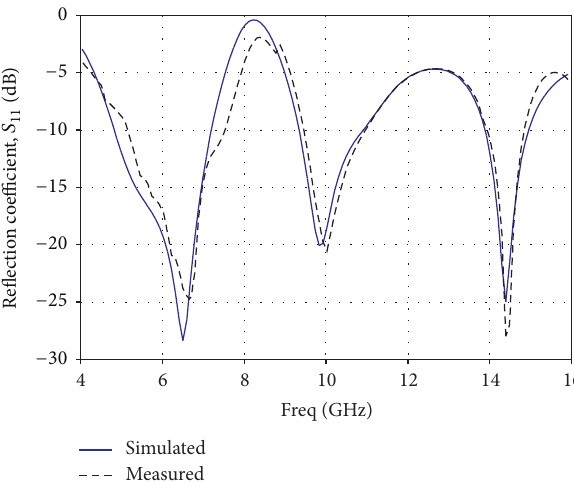
Figure 9: Magnitude of the simulated and measured reflection coefficient 𝑆 11 (dB) versus frequency (GHz) for SRR based PIFA.